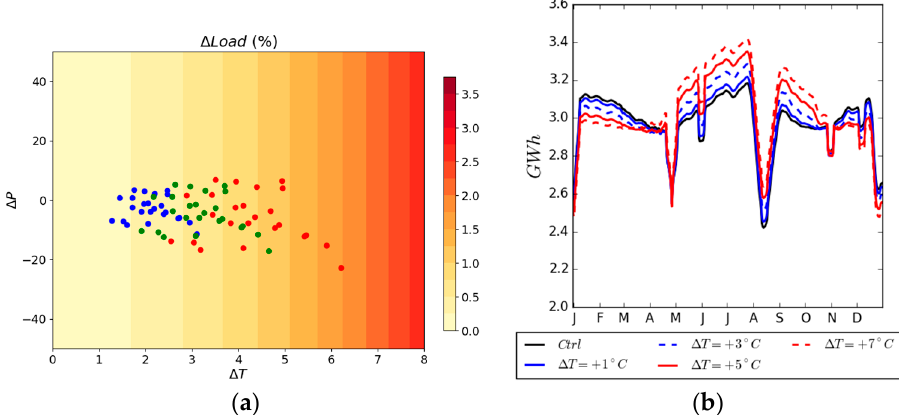
Figure 8. ( a ) Average daily load changes (%) from control period to future periods. Dots show expected temperature and precipitation changes as illustrated Figure 4. ( b ) Average inter-annual cycle of energy load obtained for control period and four temperature increase scenarios.